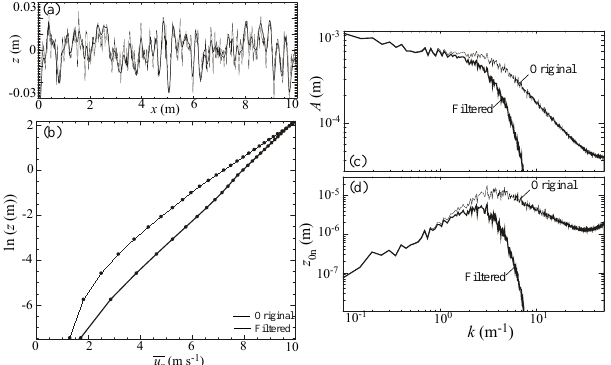
Figure 9. Demonstration of the dependence of z 0 values on the multi-scale nature of microtopography. (a) Plot of a profile through the Soda Lake smooth site (thin curve). Also shown is the same plot with diffusive smoothing (thicker curve). Smoothing main- tains the amplitude of microtopographic variations at large spatial scales (i.e., the amplitude spectrum is unchanged at large scales) but removes some of the small-scale (high-wavenumber) variabil- ity. (b) Plots of the mean velocity profiles predicted by PHOENICS over the original and filtered profile. (c) Amplitude spectra of the two plots in (a) . (d) Contributions of each Fourier mode to the z 0 values for the two plots in (a)